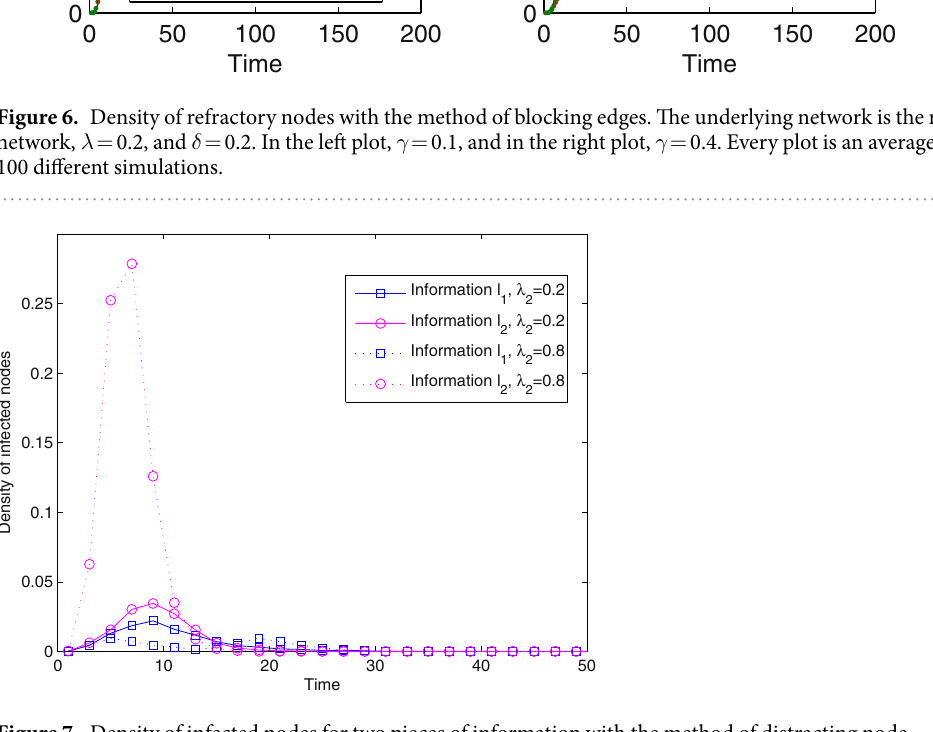
Figure 7. Density of infected nodes for two pieces of information with the method of distracting node attention. The real network mediates the diffusion, T = 0, λ = 0.2, and δ =